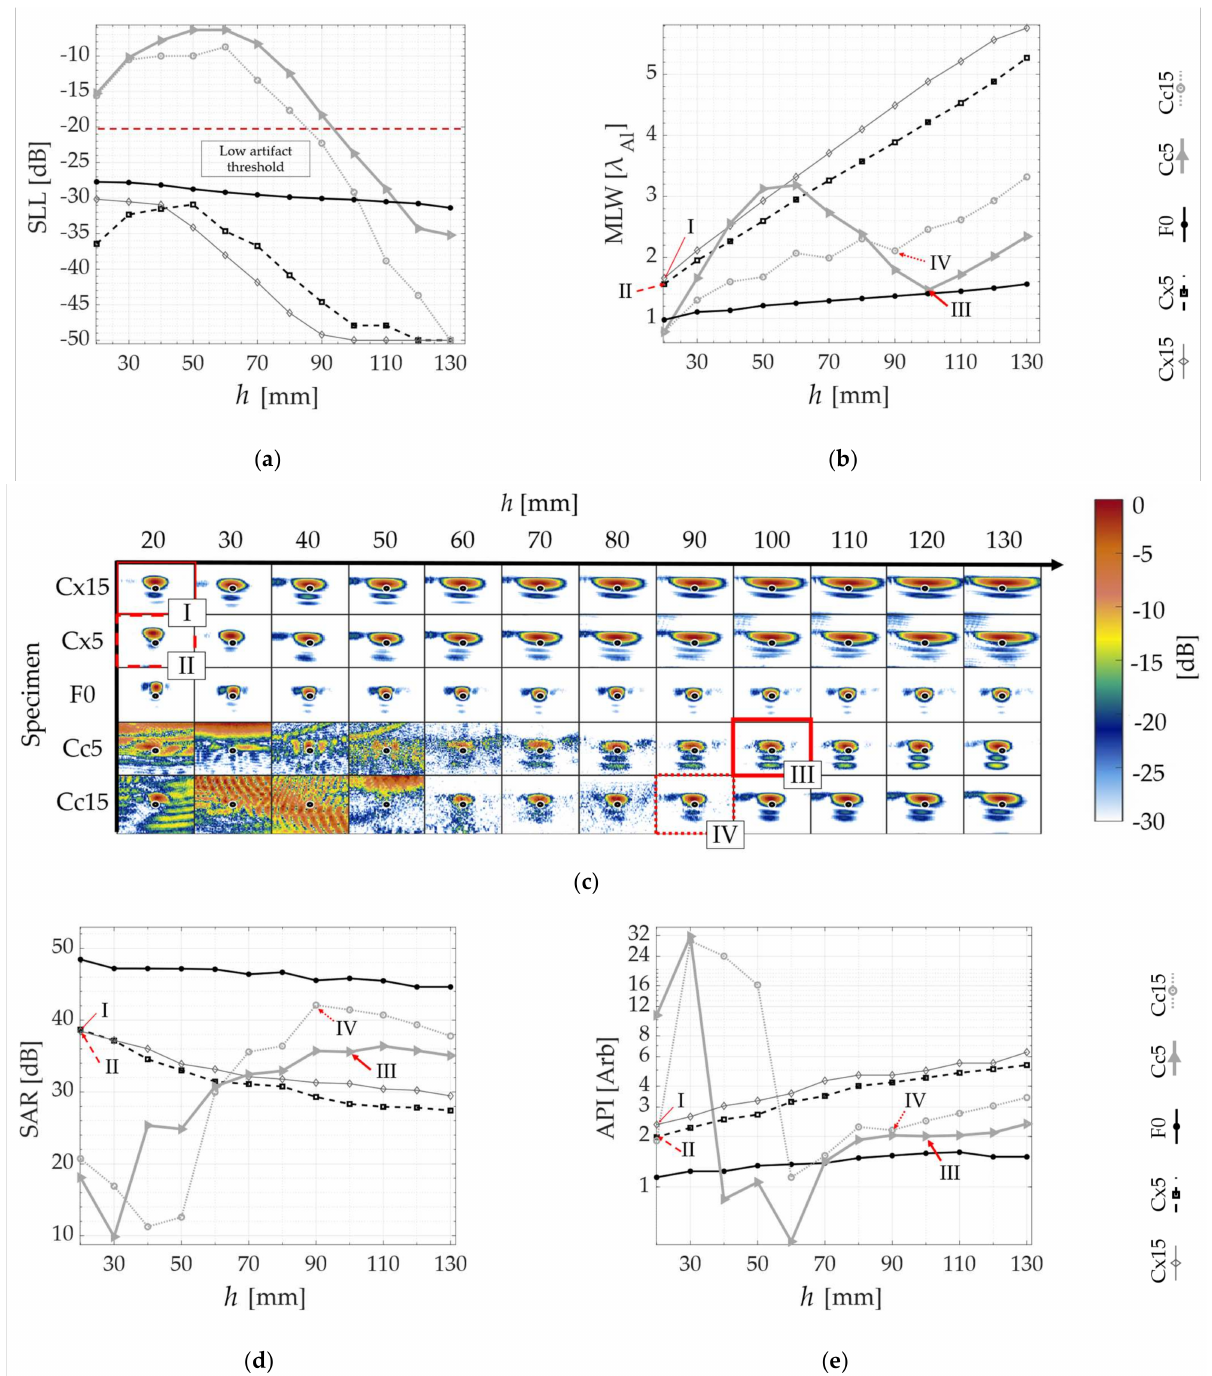
Figure 8. PSOM and experimental results from the SDH at 40 mm depth inside each specimen: ( a ) SLL obtained from PSF ( x ) at each standoff h ; ( b ) MLW vs. h ; ( c ) TFM images at different probe standoffs h in each of the five specimens; ( d ) SAR vs. standoff; ( e ) API vs. standoff. The numbers I, II, III and IV indicate the optimal probe standoffs selected by the